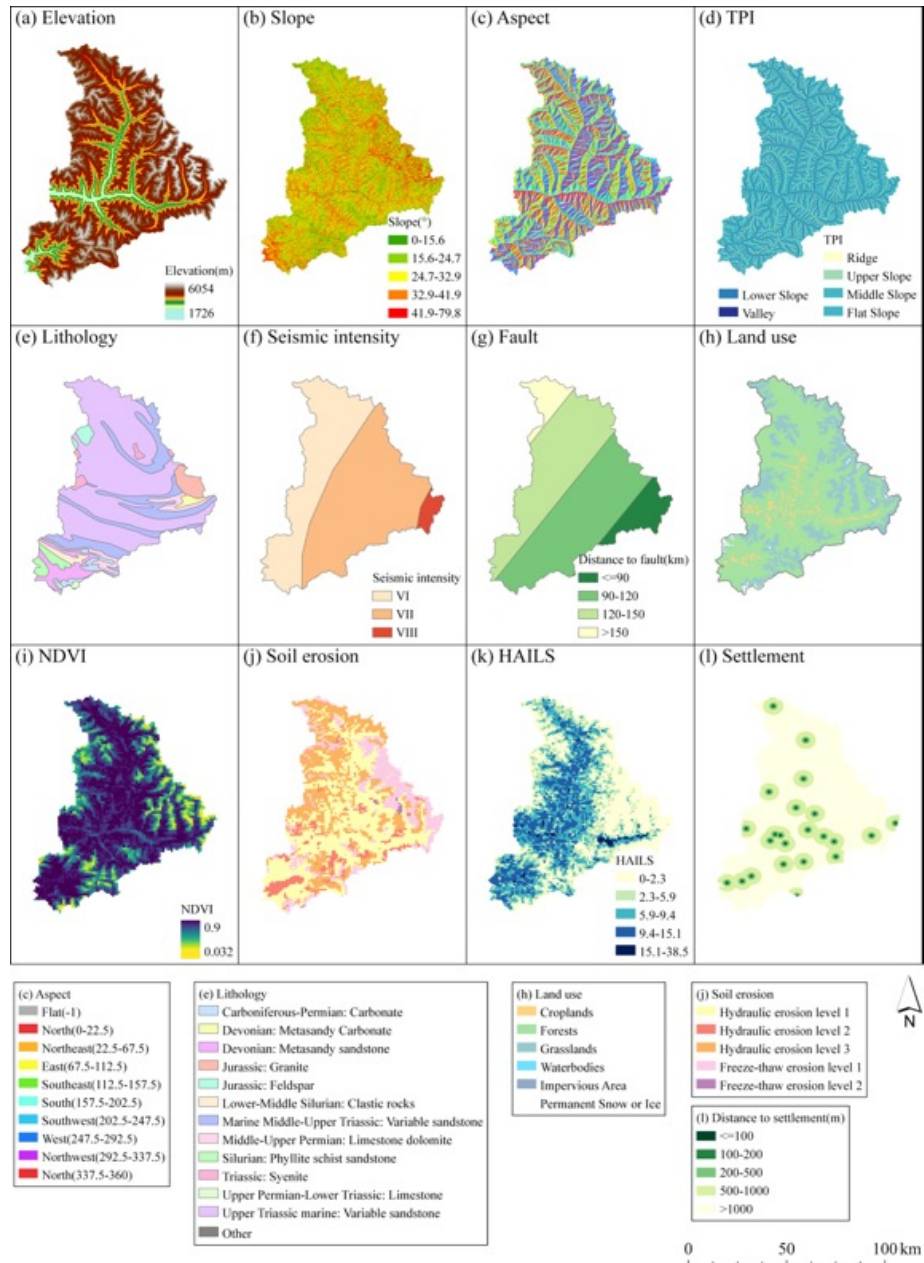
Figure 2. Thematic maps of conditional factors. ( a ) Elevation, ( b ) slope, ( c ) aspect, ( d ) TPI, ( e ) lithology, ( f ) seismic density, ( g ) fault, distance from mapping unit to the Longmen Shan Fault. ( h ) land use, ( i ) NDVI, ( j ) soil erosion, ( k ) HAILS, ( l ) settlement, distance from mapping unit to the nearest settlement.